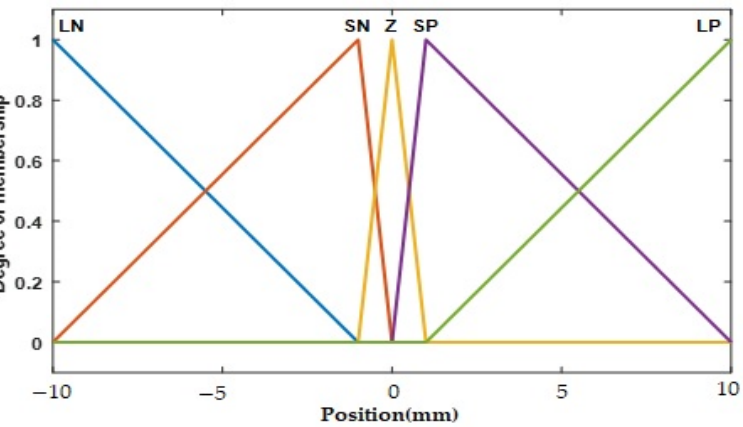
Figure 8. Block diagram of the fuzzy FOPID controller.